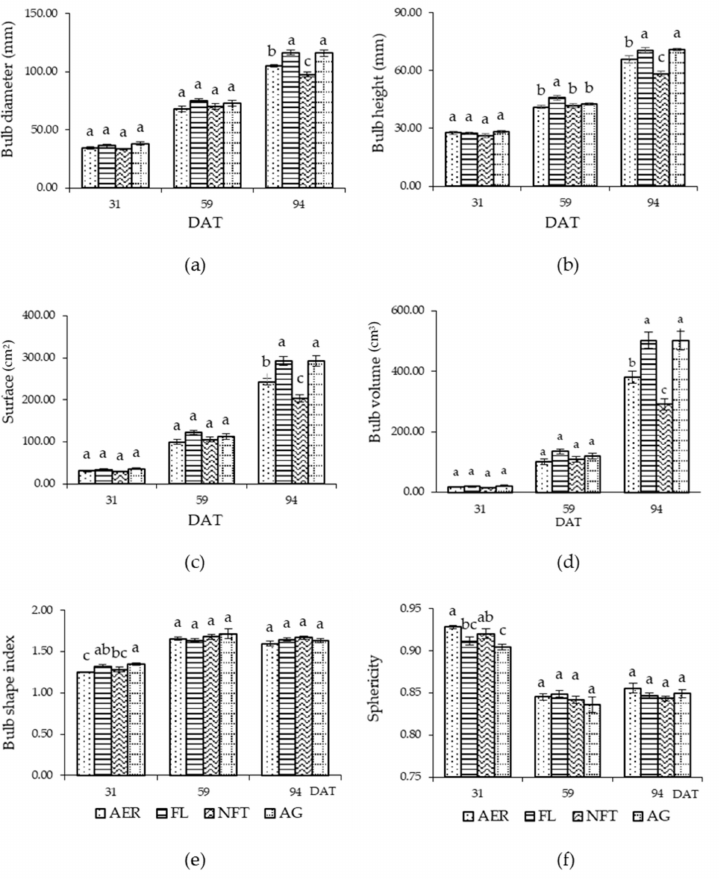
Figure 6. Impact of the CSCS on bulb characteristics: ( a ) the diameter (mm); ( b ) the bulb height (mm); ( c ) the surface of the bulb (cm 2 ); ( d ) the volume of the bulb (cm 3 ); ( e ) the bulb shape index and ( f ) the sphericity of the bulb during the 3 samplings (I, II, III), i.e., 31, 59, and 94 DAT. Vertical bars indicate ± standard errors of means of ten (10) measurements per replicate. Similar letters indicate non-significant differences at p ≤